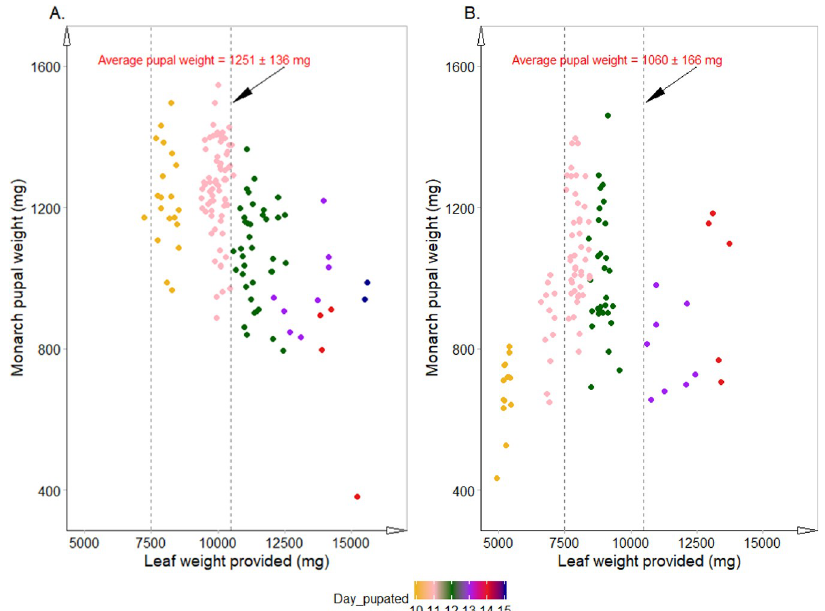
Fig 3. Individual monarch pupal weights (mg) plotted against individual weights (mg) of common (A) and tropical (B) milkweed leaf provided to each larva. Data were combined over all treatments and bioassay runs. The different colored dots represent the range of days it took the monarchs to pupate (see legend). The vertical dotted lines bound monarch pupae that were provided 7500 and 10,500 mg of milkweed leaf. The average weights of these pupae are